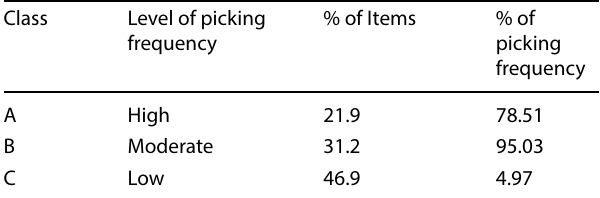
Table 6 SKUs classification based on ABC analysis